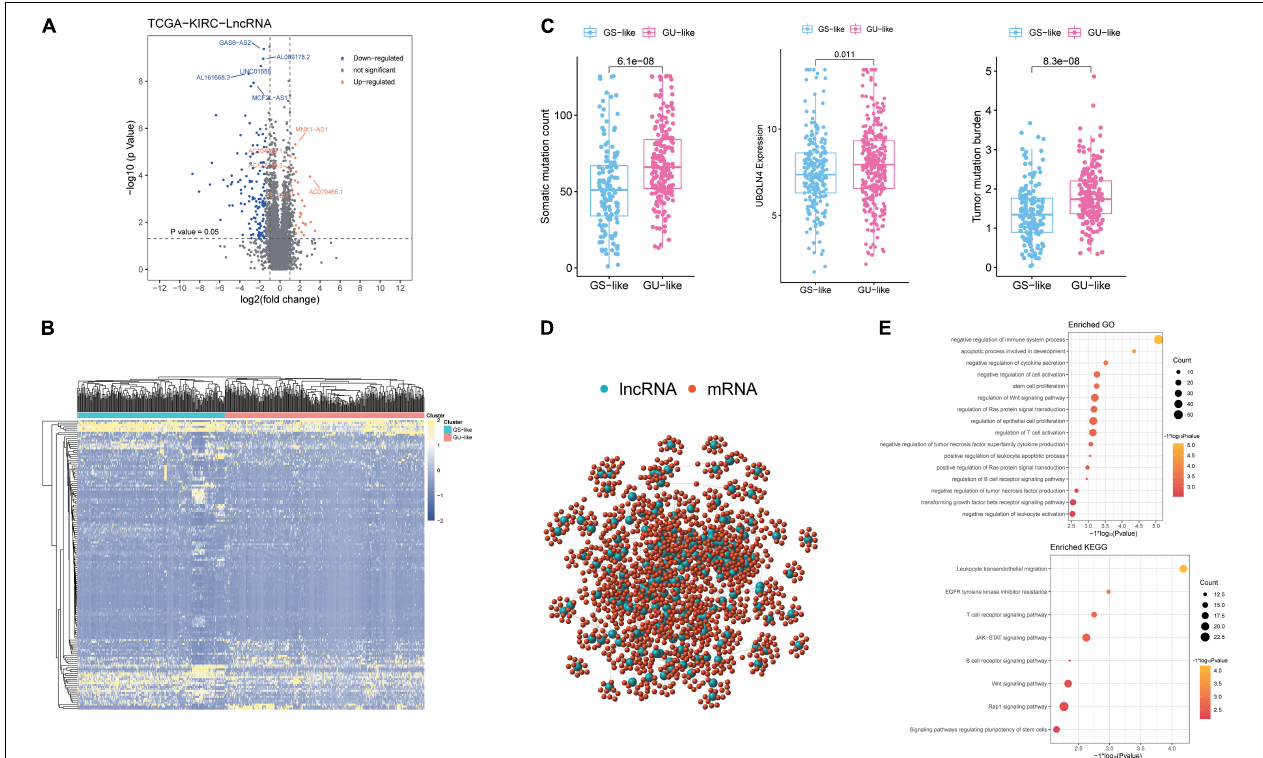
FIGURE 1 | Identification and functional annotations of genomic instability-related lncRNAs in patients with ccRCC. (A) Volcano plot of differentially expressed lncRNAs between the GU-like group and the GS-like group. The right orange labeled lncRNAs were the expression of lncRNAs, which were significantly higher in the GU-like group than the GS-like group, and the left blue labeled lncRNAs were the expression of lncRNAs, which were significantly lower in the GU-like group than the GS-like group. |LogFC| > 1.5 and p < 0.05 were used as the criteria for screening differentially expressed lncRNAs. (B) Unsupervised clustering of 525 ccRCC patients based on the expression pattern of 148 candidate genomic instability-derived lncRNAs. The left blue cluster was the GS-like group, and the right orange cluster was the GU-like group. (C) Boxplots of somatic mutations count, UBQLN4 expression level, and tumor mutation burden in the GU-like group and GS-like group. Somatic mutations count, UBQLN4 expression level, and tumor mutation burden in the GU-like group were significantly higher than those in the GS-like group. Horizontal lines: median values. Statistical analysis was performed using the Mann–Whitney U test. (D) Co-expression network of genomic instability-related lncRNAs and mRNAs based on the Pearson correlation coefficient. The red circles represented mRNAs, and the blue circles represented lncRNAs. (E) Functional enrichment analysis of GO and KEGG for lncRNAs co-expressed mRNAs.